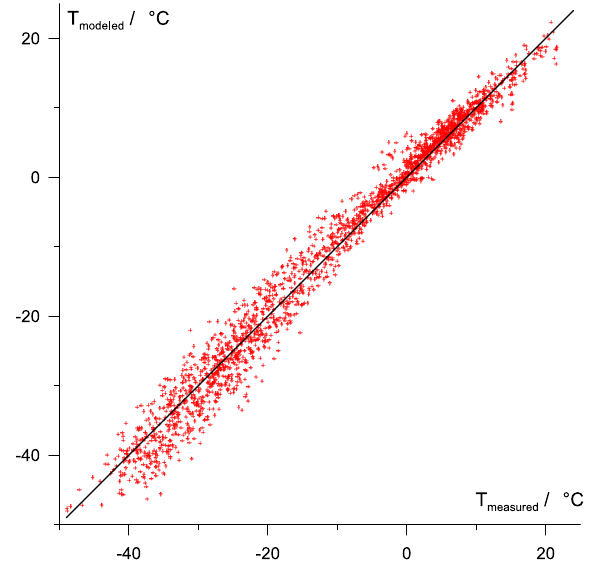
Figure 2. Modeled vs. measured daily average surface tempera- tures for in total 2066 days between 2002 and 2009. The measured surface temperatures are obtained from measurements of outgoing long-wave radiation at the Samoylov climate station (Langer et al., 2011a, b; Boike et al., 2013). The black line represents the 1:1 line.